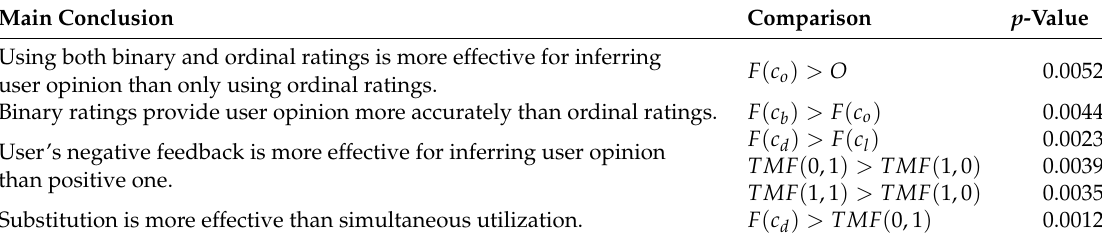
Figure 8. Performances of the nine compared methods in terms of RMSE and MAPE according to various k s. Table 4. Results of paired sample t-tests on the comparison performances for main